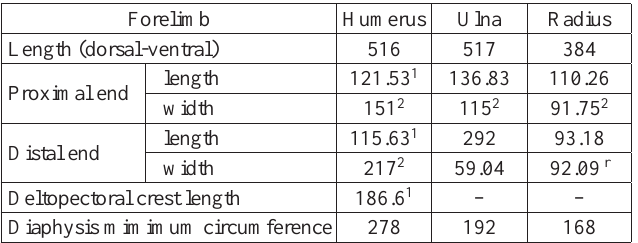
Table 1. Greatest measurements (in mm) for GPDM 205. 1 anterior-poste- rior length 2 lateral width; r reconstructed.